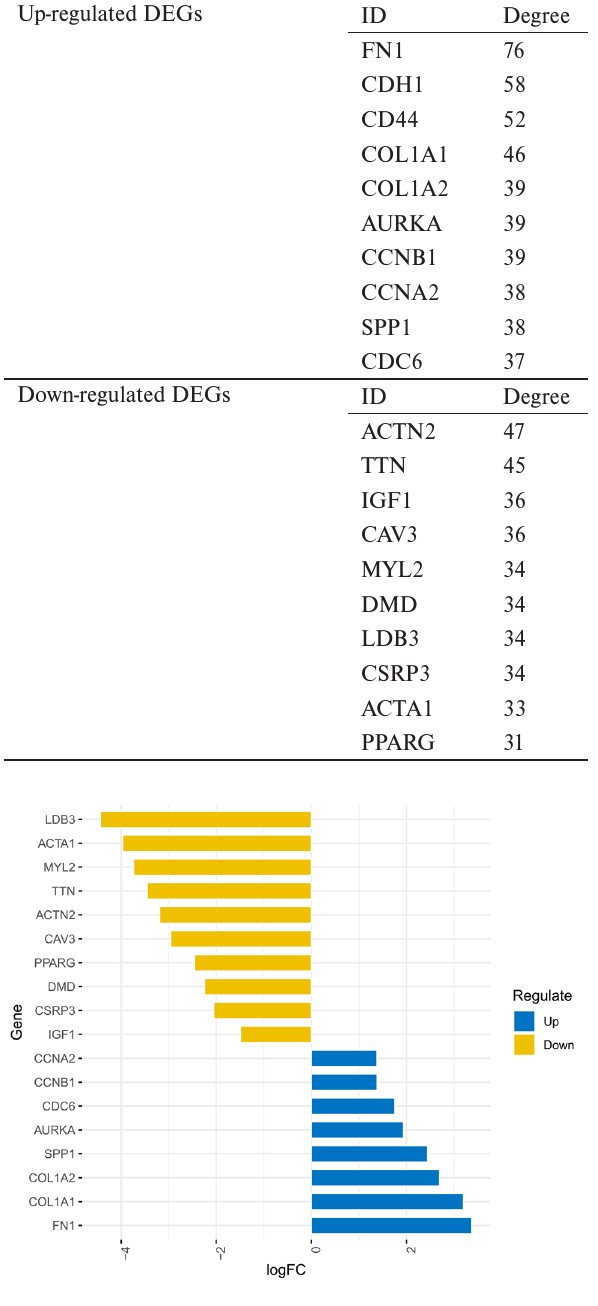
Fig. 3. TCGA database identified the differential expression of hub genes. The figure showed hub genes that meet FDR<0.05 and |log FC|>1. Blue represented up-regulated hub gens, and yellow represented down-regulated hub